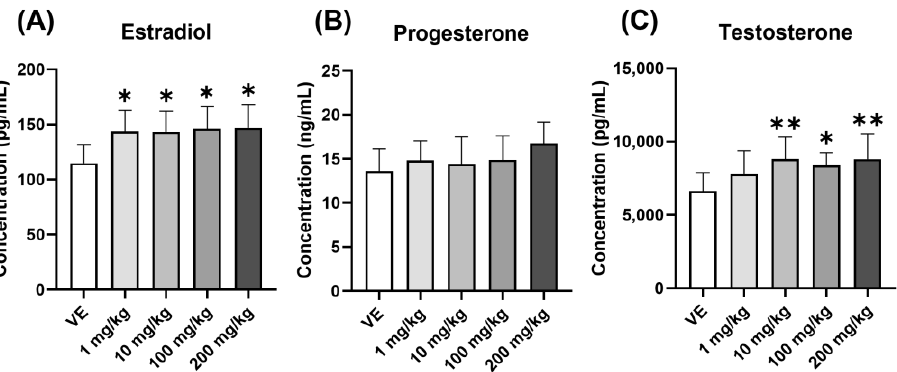
Figure 5. Changes in the concentration of steroid hormone in the serum. Confirmation of hormones in the serum of rats exposed to D5 for four weeks using ELSIA: ( A ) Estradiol concentration in serum; ( B ) progesterone concentration in serum; ( C ) testosterone concentration in serum. The values are expressed as means ± SD. * p < 0.05 and ** p < 0.01 vs. vehicle. VE—vehicle, N = 9~10.